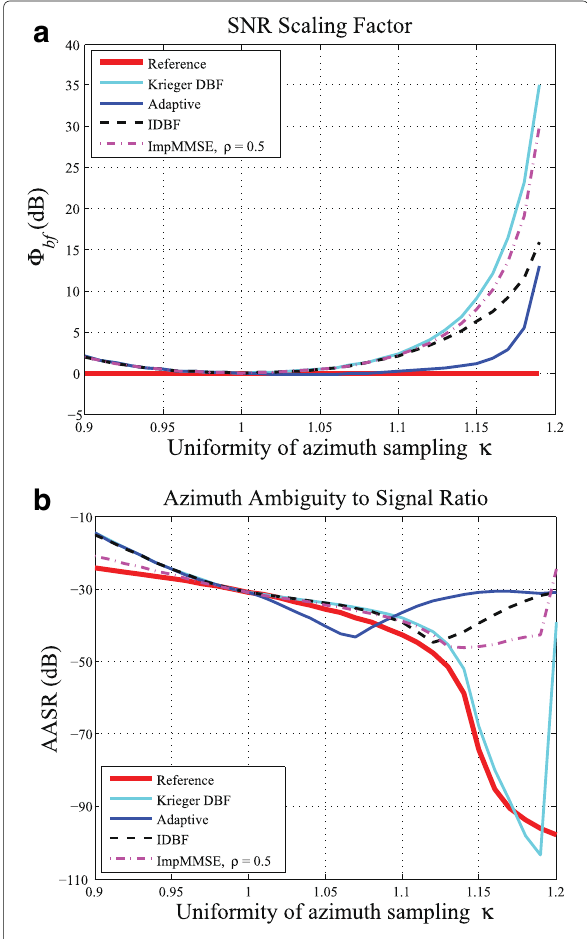
Fig. 8 Reconstruction performance achieved by different algorithms. a The value of SNR scaling factor (cid:12) bf versus the uniformity of azimuth sampling κ . b The value of AASR versus the uniformity of azimuth Fig. 9 Envelopes of spatial spectrum realized by different estimation methods for the six-channel SAR simulated